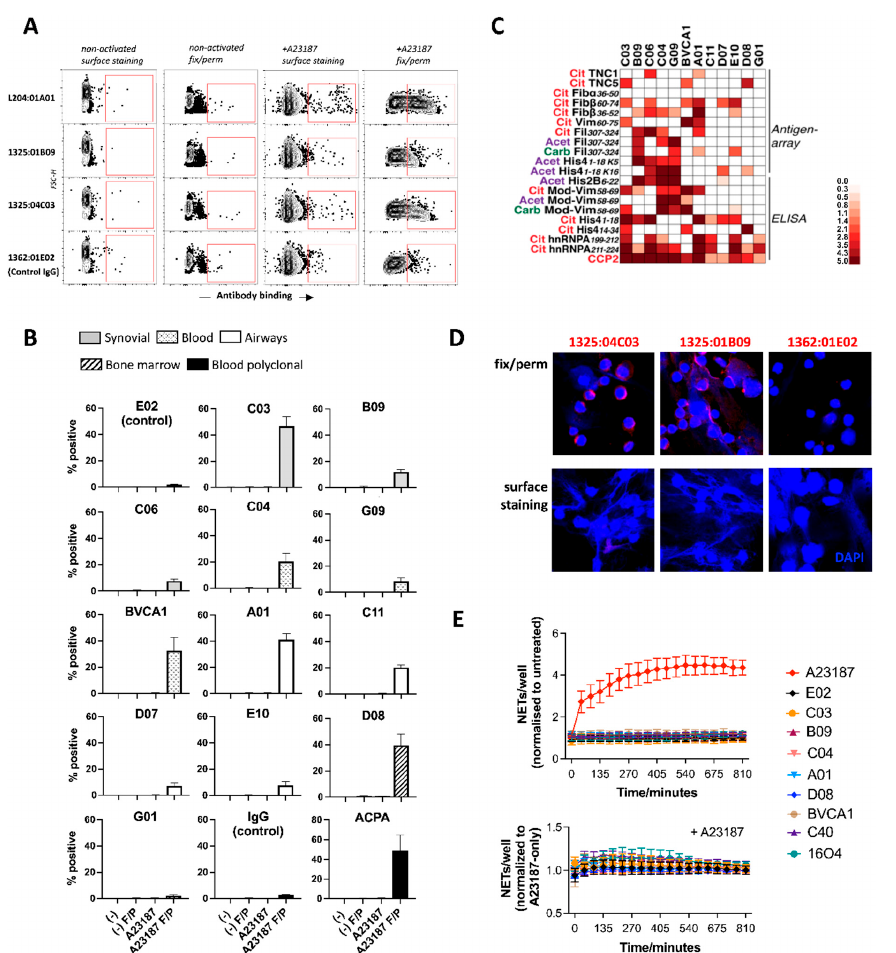
Figure 2. ACPA binding to intracellular epitopes in activated neutrophils. ACPA binding was studied to intact or fixed/permeabilized neutrophils that were either non-activated or exposed to A23187 for 45 min. Representative contour plots are shown with gated positive events ( A ) or cumulative data from three independent experiments, with staining detectable in activated and fixed/permeabilized (F/P) neutrophils only ( B ). Fine-specificity of the tested clones was analyzed to citrullinated (Cit), carbamylated (Carb) and acetylated (Acet) autoantigens ( C ). ACPA binding was analyzed by confocal microscopy to A23187-activated neutrophils in fixed/permeabilized or non-fixed samples ( D ). The effect of ACPA and control antibodies on NETosis was analyzed using IncuCyte; results are expressed after normalization to non-treated samples (( E ), upper panel). Alternatively, the cells were exposed to a moderate dose (5 µ M) of A23187 with or without the different antibodies, and values were normalized to samples treated with A23187 only (( E ), lower panel). Average values calculated from three independent experiments are